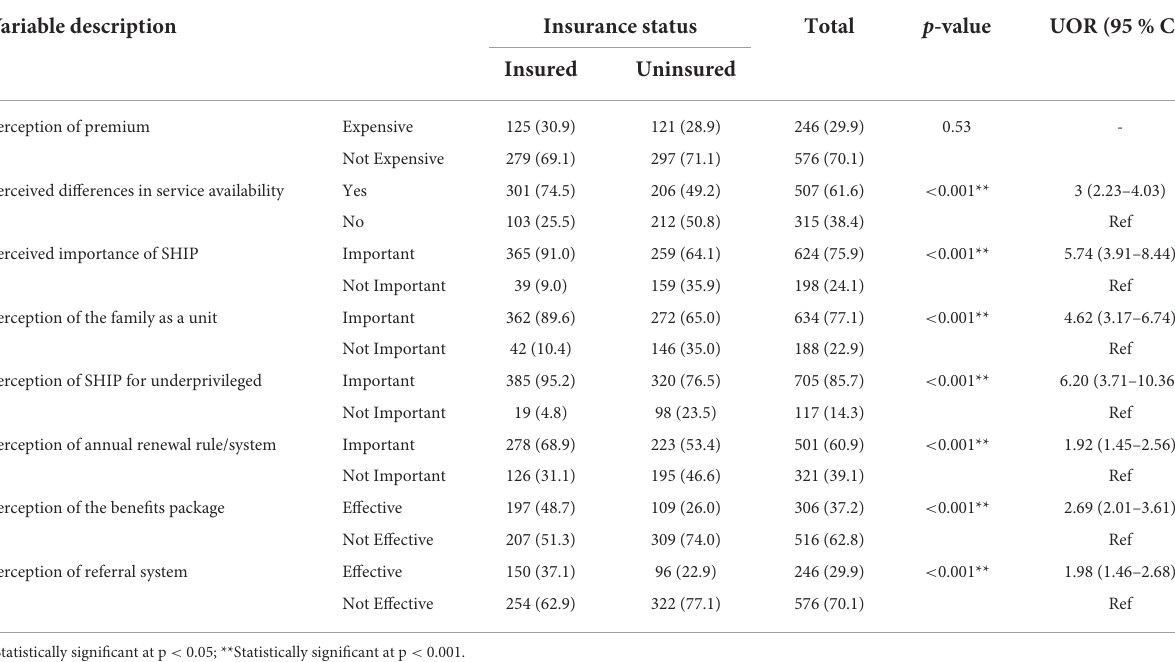
TABLE 2 Associative demand-side perceived factors among the beneficiaries.